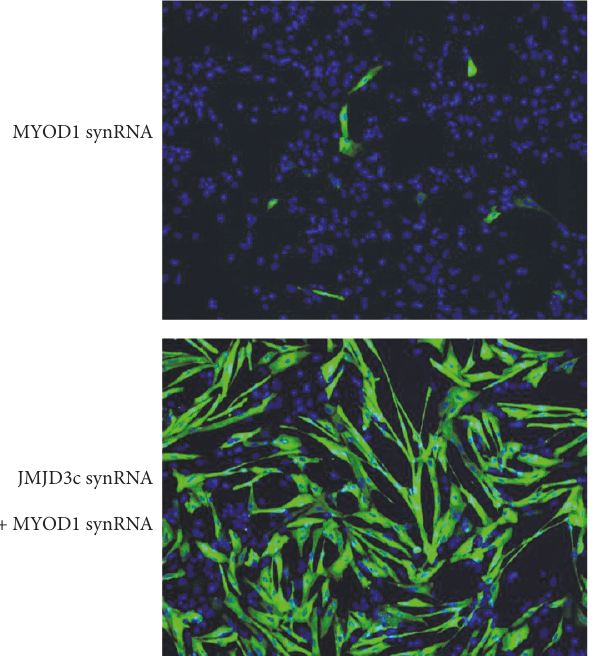
Figure 4: E ffi cient myogenic di ff erentiation of hESCs by synRNA- mediated overexpression of JMJD3c and MYOD1. Transfection of synRNAs encoding JMJD3c and MYOD1 directly converts hESCs into MHC-positive myogenic cells for 5 days post di ff erentiation. The di ff erentiation e ffi ciency was much higher in the JMJD3c/ MYOD1-overexpressing hESCs compared with the MYOD1- overexpressing hESCs. MHC, green. DAPI,